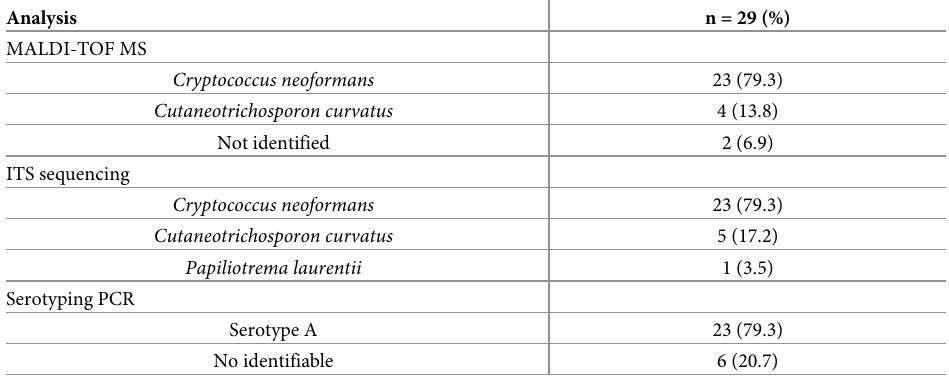
Table 2. MALDI-TOF MS, ITS sequencing, and multiplex PCR serotyping characterization.